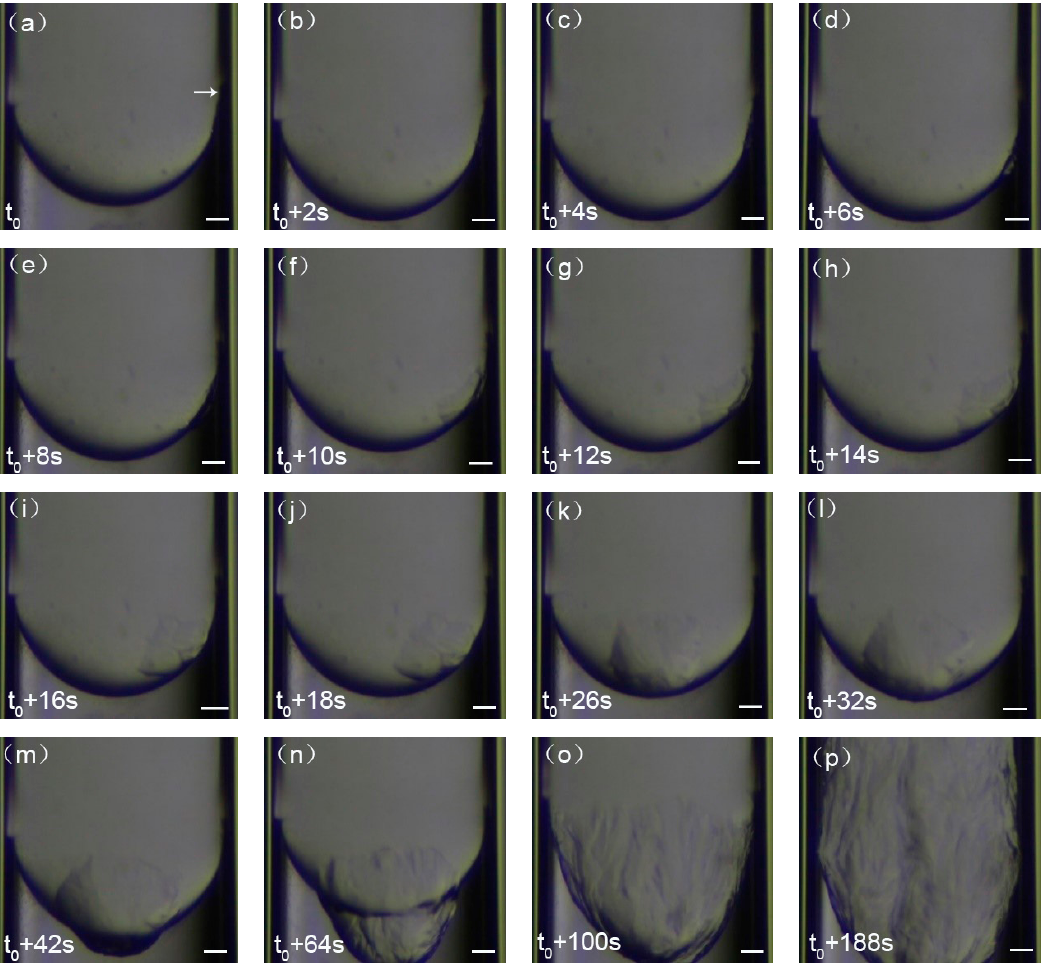
Figure 5. Reformation of CP hydrate crystals in the capillary. The scale bars in the images correspond to 50 μ m.